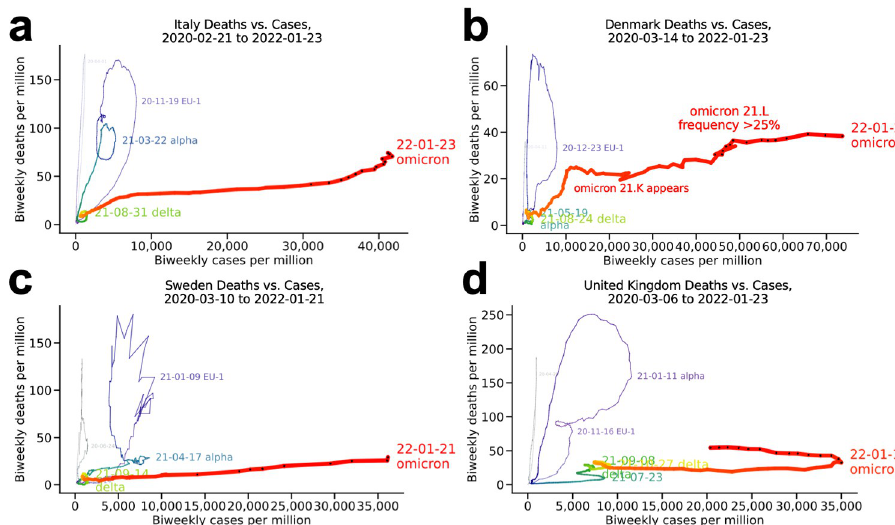
Fig 2. Select European countries. (a) Italy, (b) Denmark, (c) Sweden, and (d) United